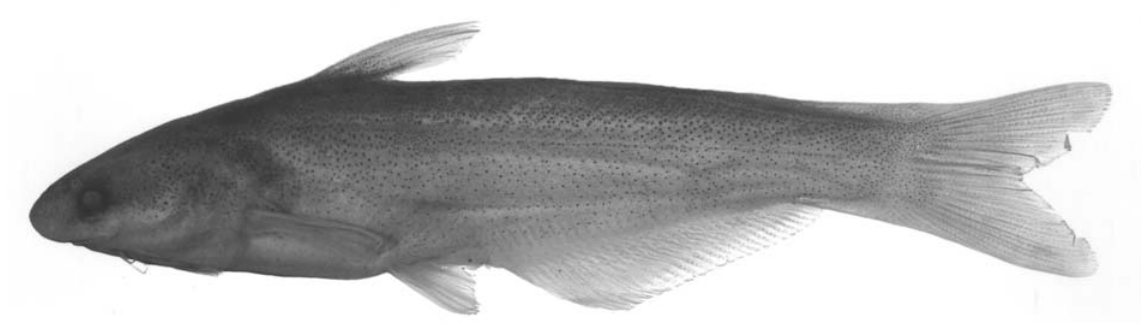
Fig. 57. Paracetopsis esmeraldas , new species, holotype, MCZ 48768, 68 mm SL; Ecuador, Esmeraldas, río Esmeraldas basin, río Blanco, 4 km above junction with río Quininde (0°20’N,